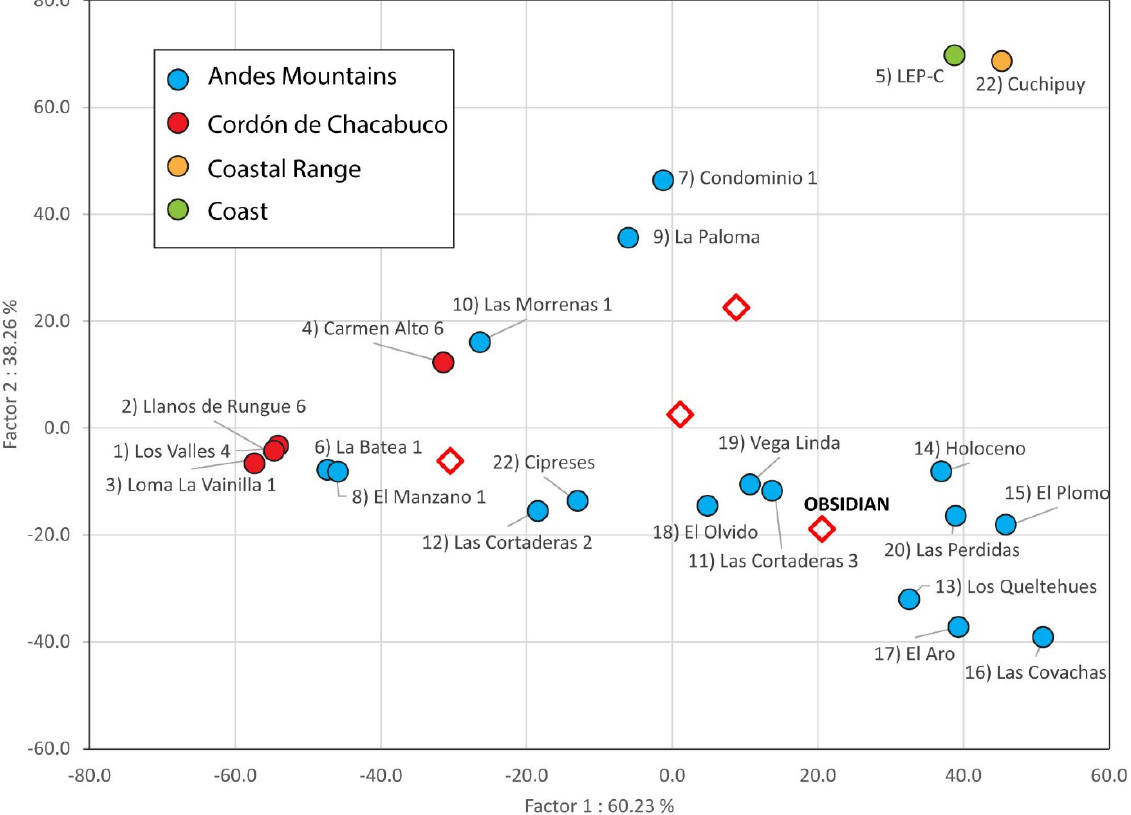
Figure 3. Distribution based on Factors 1 & 2 of the main component analysis of the sites studied and raw materials